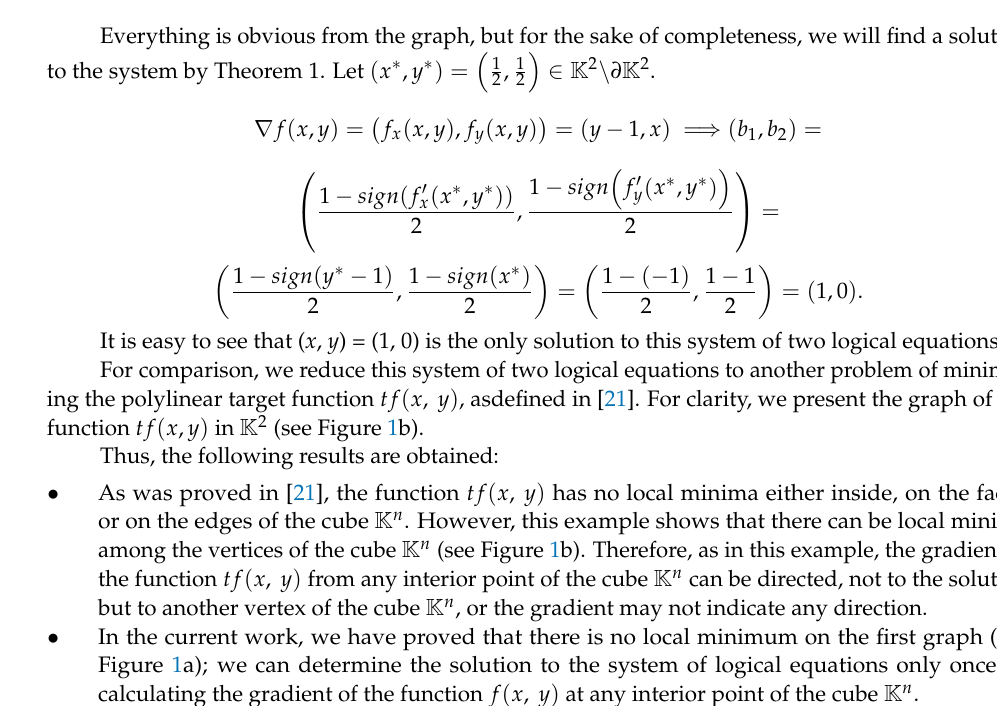
Figure 1. The left graph ( a ) is the graph of the function f ( x , y ) = xy − x + 1. The right graph ( b ) is the graph of the function tf ( x , y ) = ( xy − x + 1 ) + ( 2 xy − x − y + 1 )